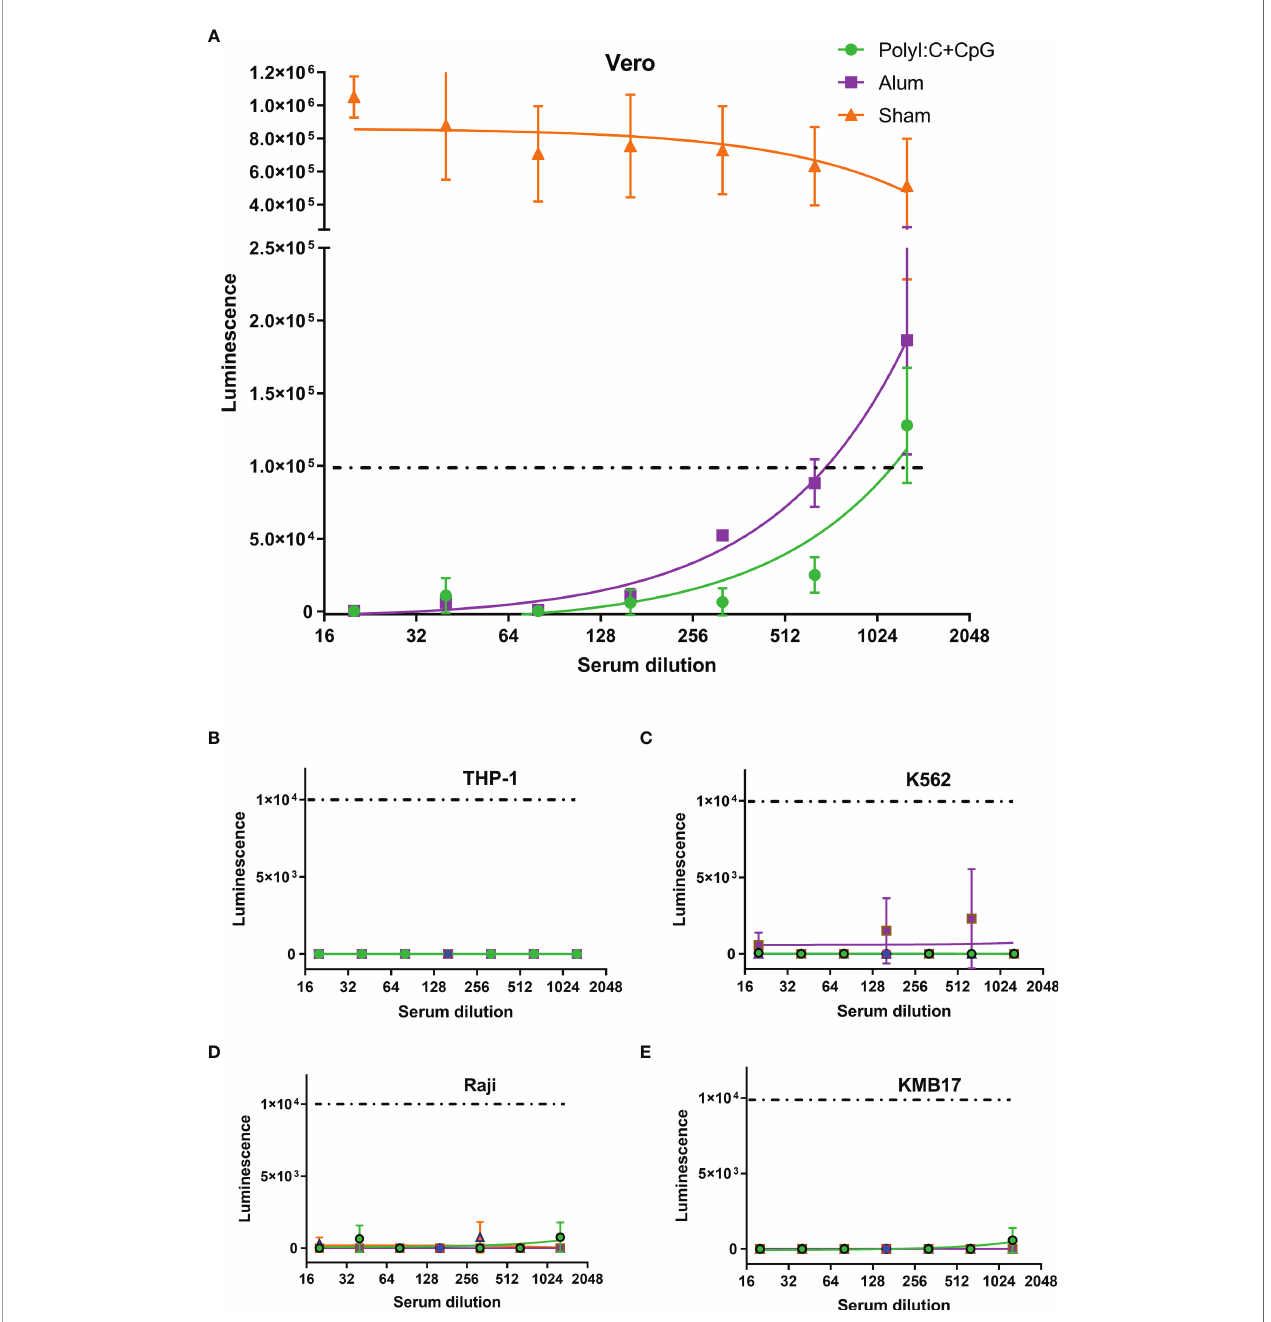
FIGURE 3 | Th2-oriented immune serum after S1-based subunit vaccine administration does not enhance infection in vitro . (A) Pseudovirus-based neutralization assay of immune serum in Vero cells that express ACE2. (B – E) Assay of pseudovirus-based antibody-dependent enhancement of infection with immune serum in different Fc g R-expressing cells. Poly(I:C)+CpG, nucleic acid-adjuvanted plus S1-puri fi ed protein immune serum; Alum, alum-adjuvanted plus S1-puri fi ed protein immune serum; Sham, serum from mice intramuscularly administered PBS instead of immunogens. All of the above analyses were performed using pooled serum from each immunized group. The means and standard deviations of duplicates are